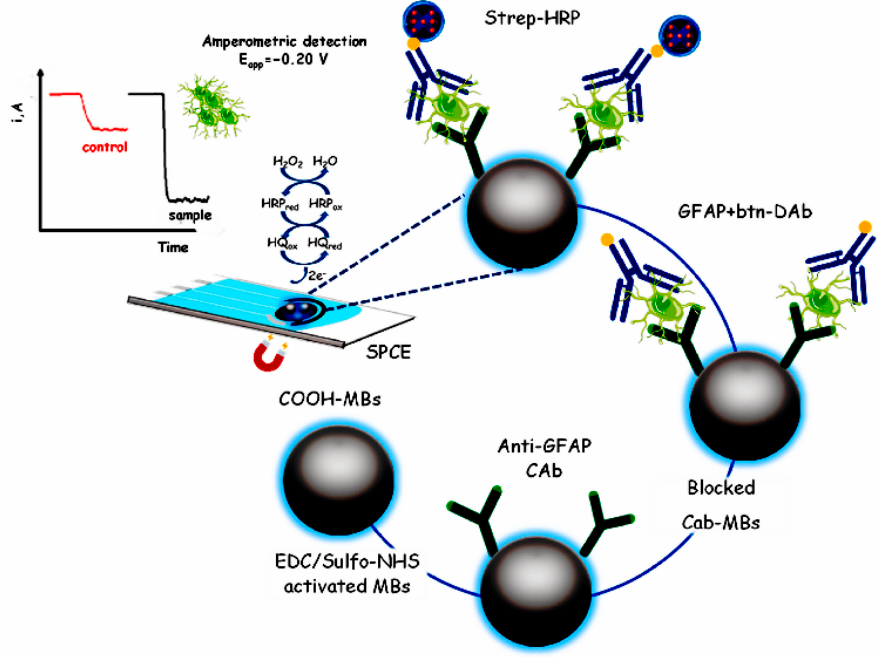
Figure 14. Schematic display of the MB–assisted immunoplatform preparation for the amperometric assay of GFAP [101]. Copyright (2022) Elsevier.